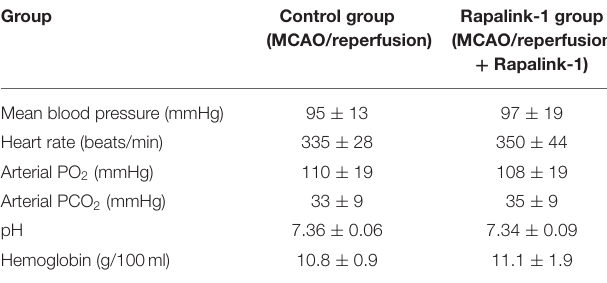
TABLE 1 | Hemodynamic and blood gas parameters for the control and the Rapalink-1-treated group at 2h of reperfusion and just before the determination of blood–brain barrier